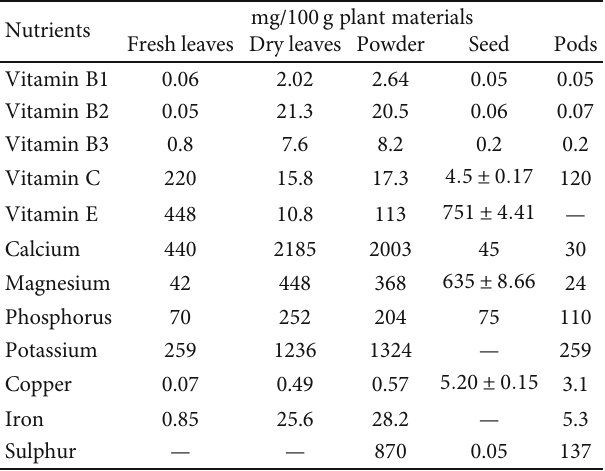
Table 6: The vitamin and mineral compositions of leaves, seeds, and pods. Nutrients